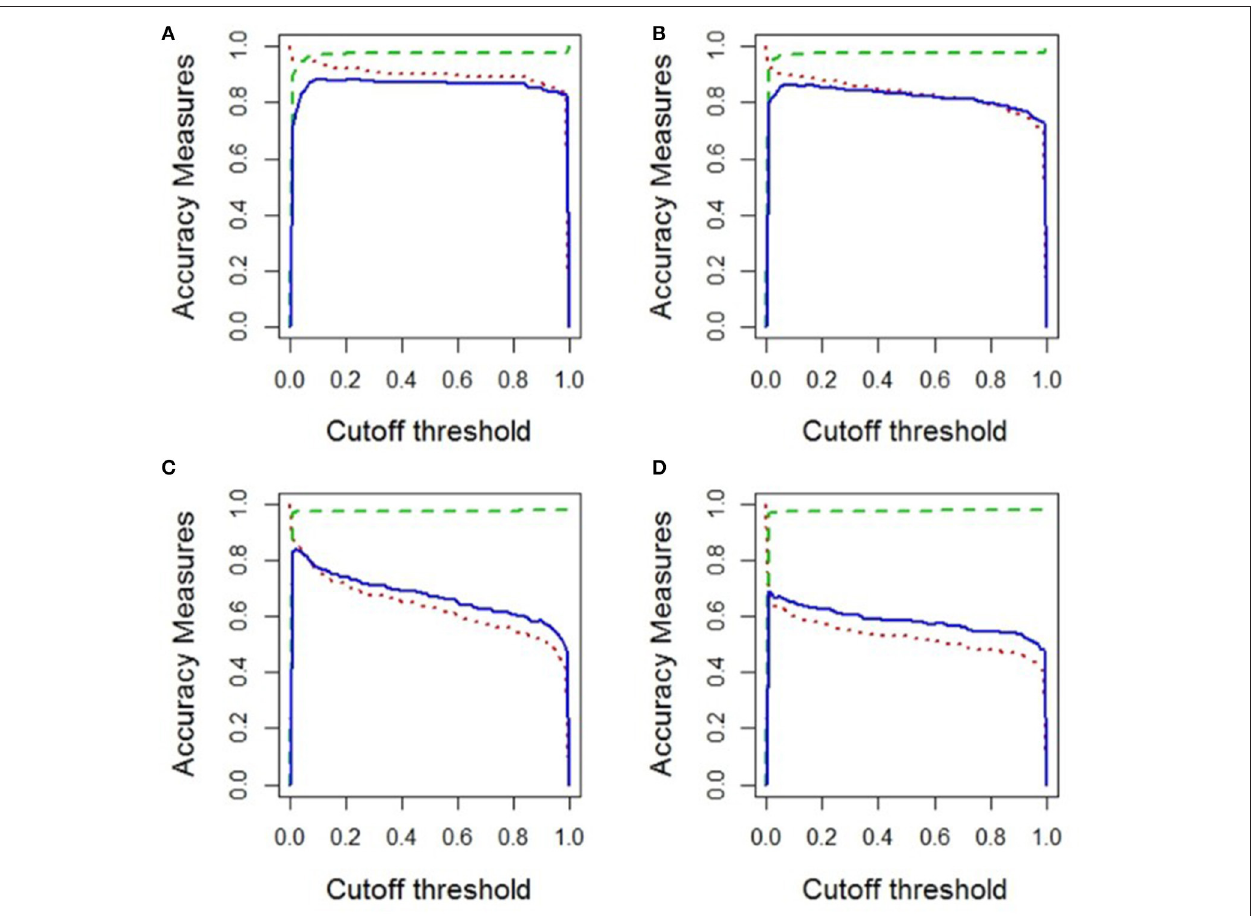
FIGURE 4 | An example of the plots used to assess the accuracy of parameter combinations, using kappa, specificity, and sensitivity measures. The accuracy measures vary from zero to one, in which a value of one represents a perfect accuracy measure and zero a poor one. The cutoff threshold represents the number of repeat simulations a cell was required to have been colonized, in order to be characterized as a presence in the final model evaluation, with 1.0 being 100% and 0.0 being 0% of repeats. (A) represents a set of parameter combinations that predict a goby presence close to that of the observed presence from the literature. In comparison, plots (B–D) demonstrate a decrease in model